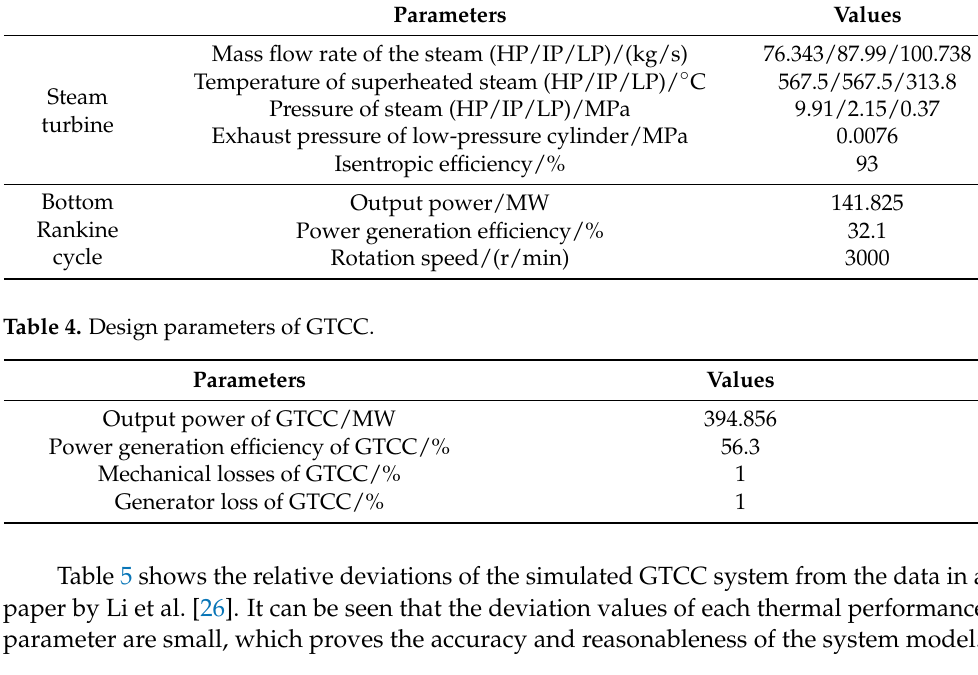
Table 5. Validation of model against GTCC case from Li et al.